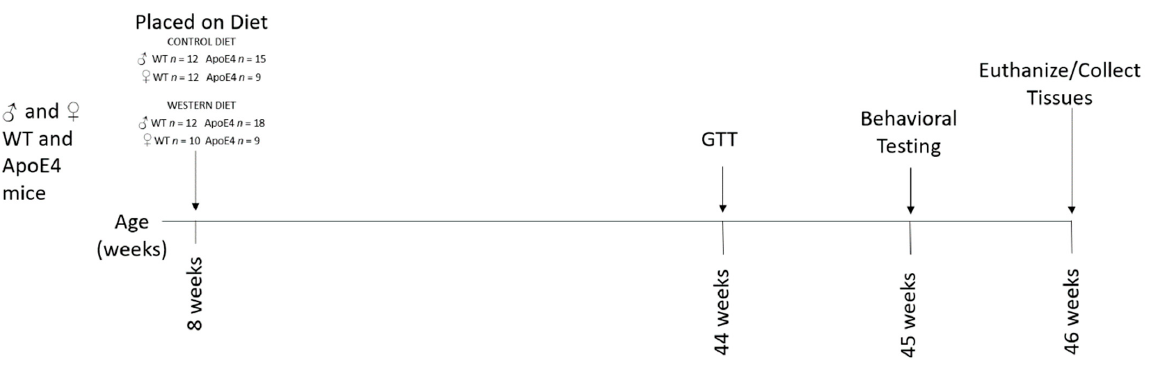
Figure 2. Experimental timeline (GTT = glucose tolerance testing). See Section 4: Methods for details.